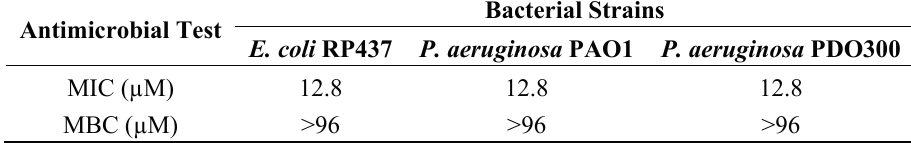
Table 1. Minimum Inhibitory Concentration (MIC) and Minimal Bactericidal Concentration (MBC) values of TN-5 on bacterial strains used in this study (based on three biological replicates). Antimicrobial